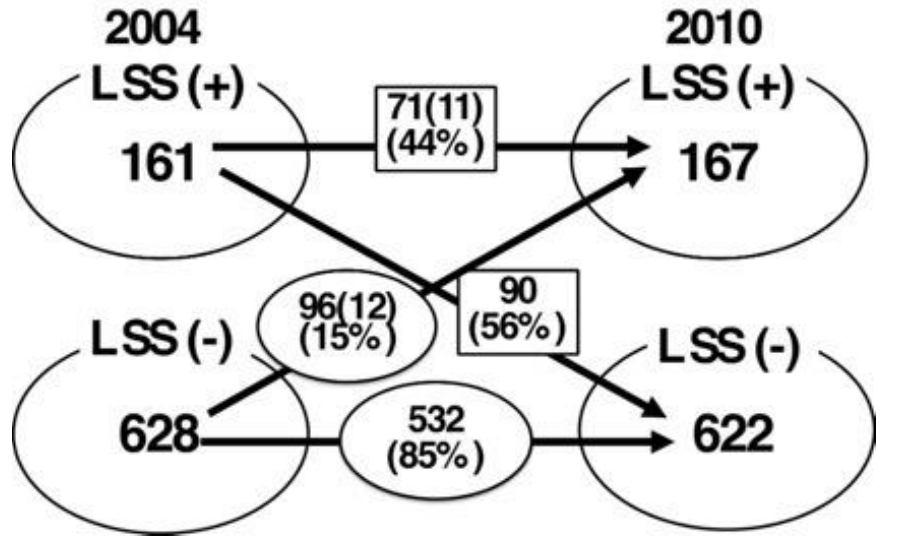
Figure 2. Time course of LSS symptom for six-year duration: All subjects.